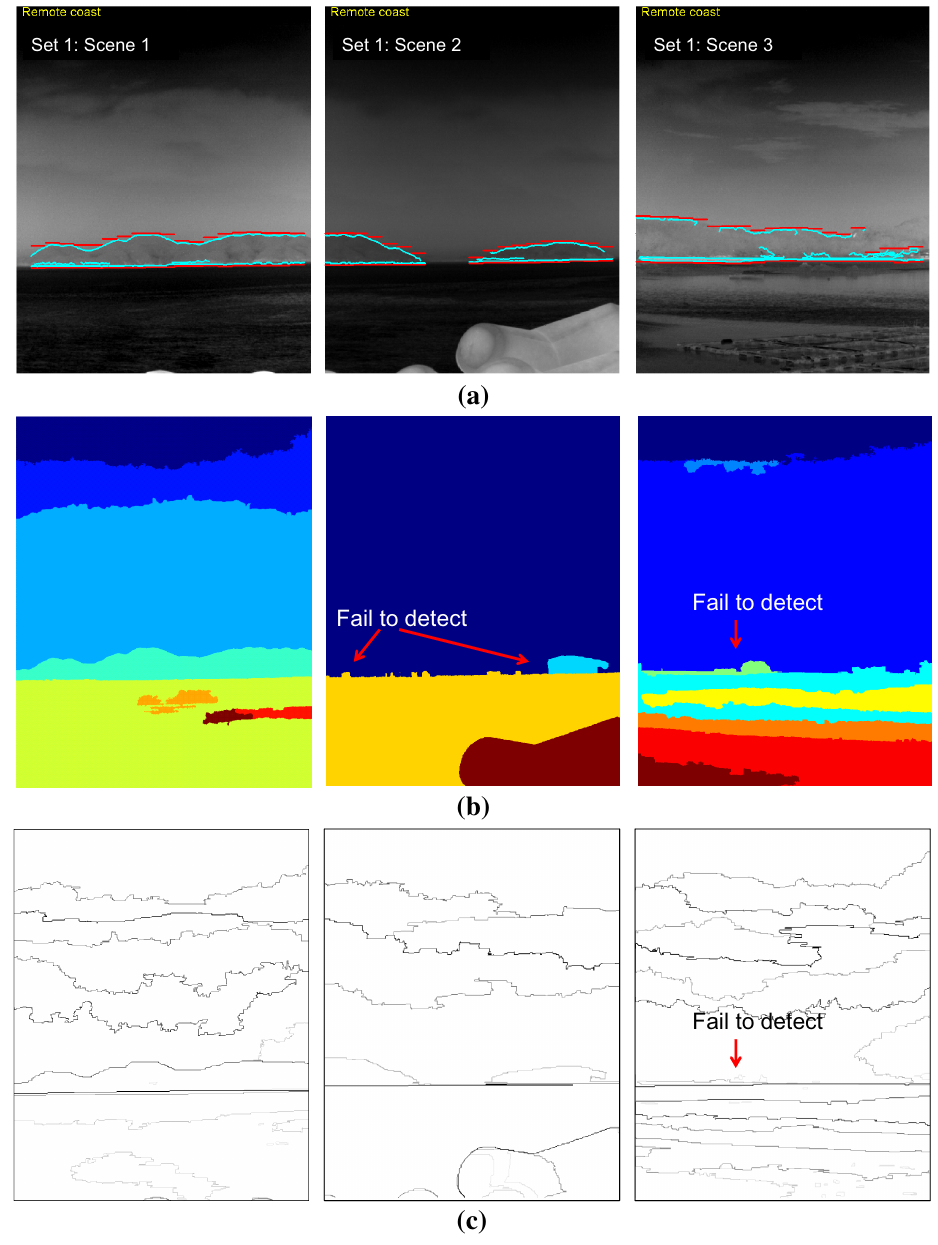
Figure 23. Comparison of the coastal region detection results for Test Set 1: ( a ) proposed coastal region detection; ( b ) mean-shift segmentation-based method [28]: Scene 1 was successful; Scenes 2 and 3 failed (segmentation results were displayed as partial outputs.) [28]; ( c ) statistical region merging method